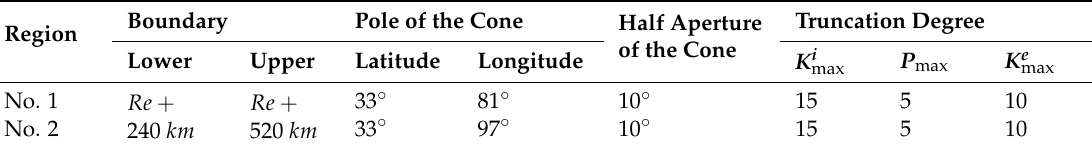
Table 1. Parameter values associated with R-SCHA